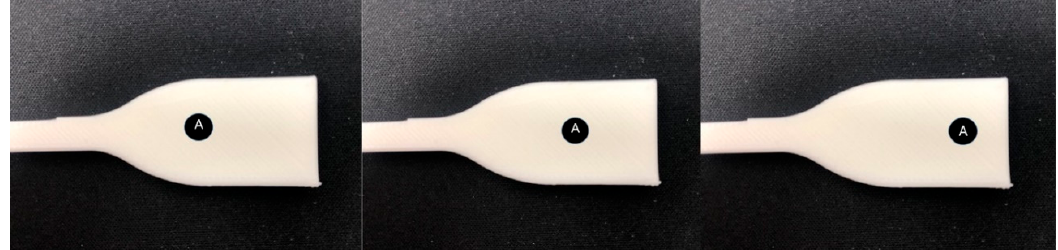
Figure 2. Measurement locations for the Fourier transform infrared (FTIR) spectroscopy.